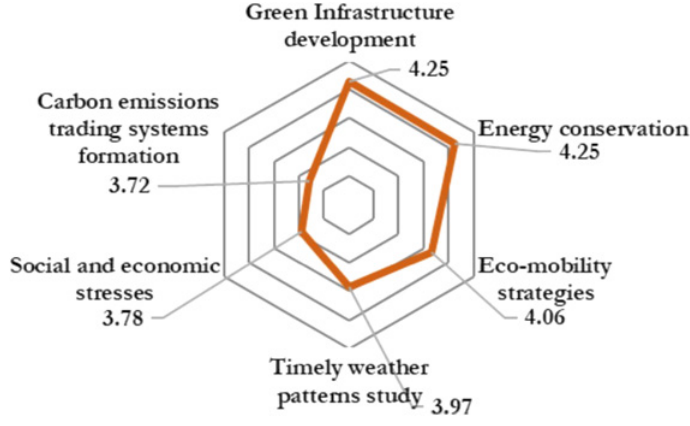
Figure 5 Influence of Climate Change on Resilience